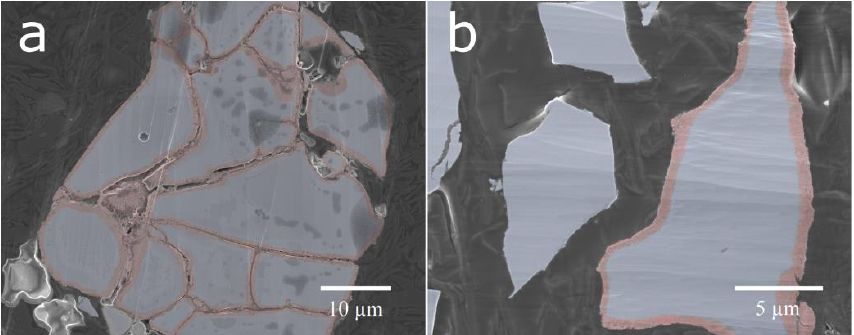
Figure 5. XRD patterns of cycled material, material from the ultrasonic bath, and ball-milled material, respectively. ( (cid:7) ) RE(OH) 3 .